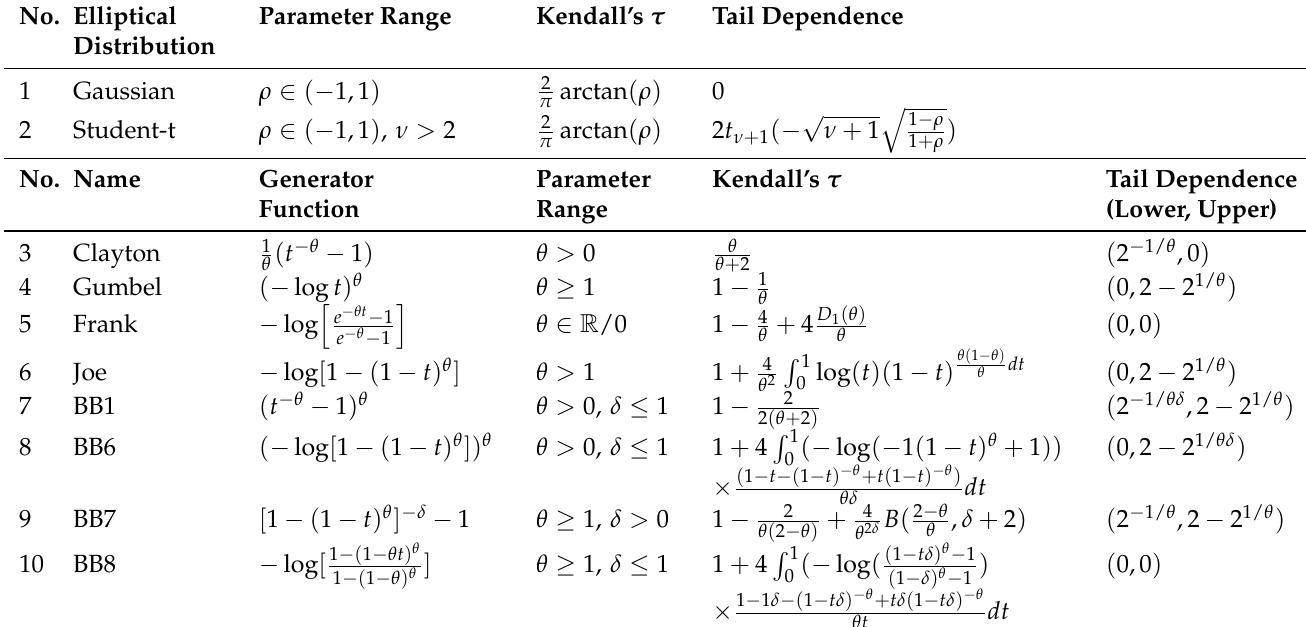
Table 1. Copula component.